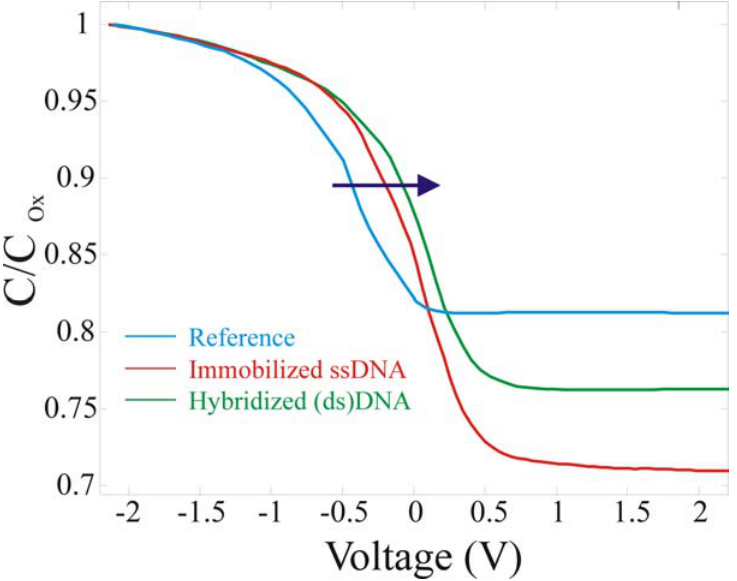
Figure 13. Normalized Capacitance Voltage curves of the reference sample (light blue line), fully processed ssDNA (red line) and of the hybridized dsDNA (green line). The arrow underlines the direction of the V FB